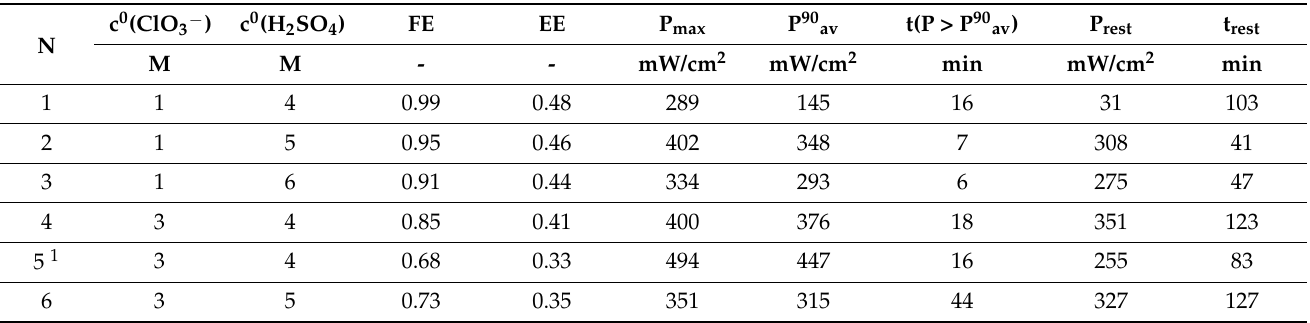
Table 1. Discharge characteristics of cells (chlorate cathode and hydrogen gas diffusion